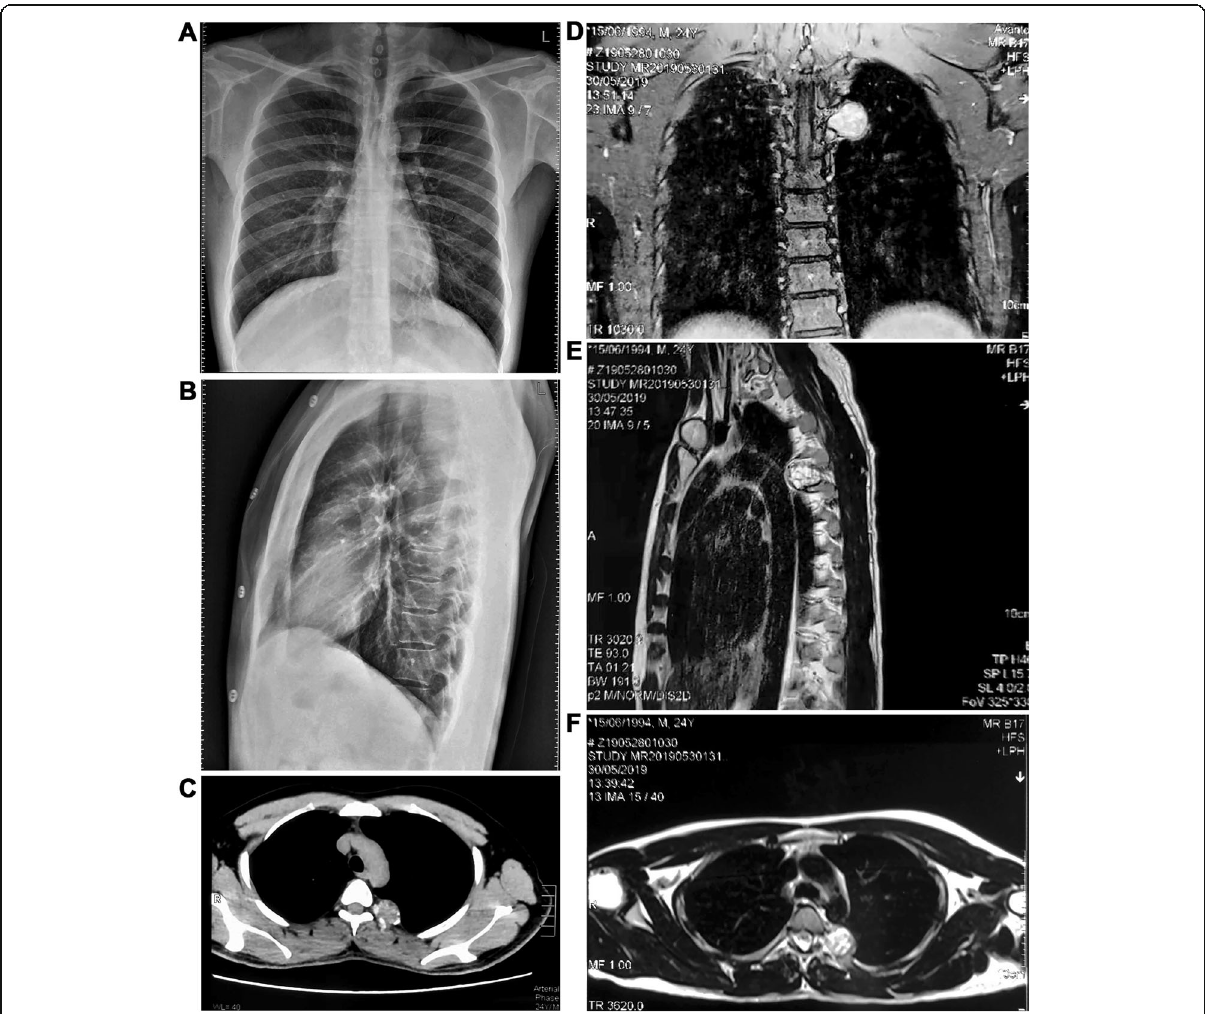
Fig. 1 Radiological appearance of chondromesenchymal hamartoma of the chest wall in a 24-year-old adult. a , b DR suggested a left posterosuperior mediastinal mass and bronchitic changes. c CT revealed a benign expansile lesion in the posterior part of the left fifth rib with interior punctate calcifications. d - f MRI revealed a well-circumscribed expansile heterogeneous soft mass closely adjoining the fifth vertebral body in the left posterior mediastinum. DR, digital radiography; CT, computed tomography; DR, digital radiography; MRI, magnetic resonance